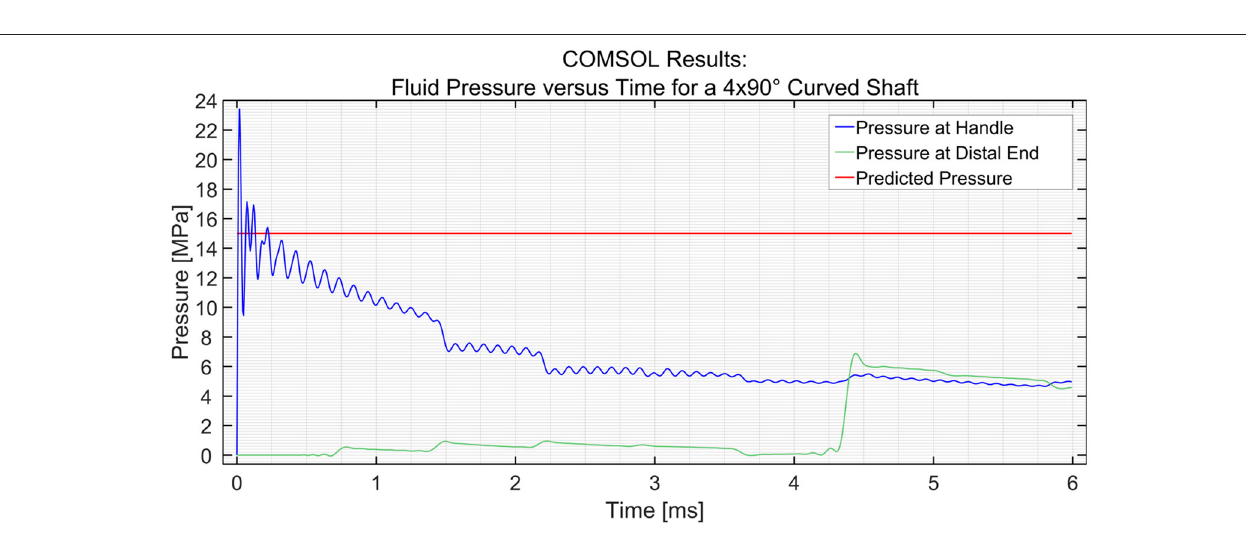
FIGURE 6 | Pressure variation at the distal end and input vs. time in the PTFE Shaft for a shaft with 4 × 90 ◦ curves. The input pressure was set to 15